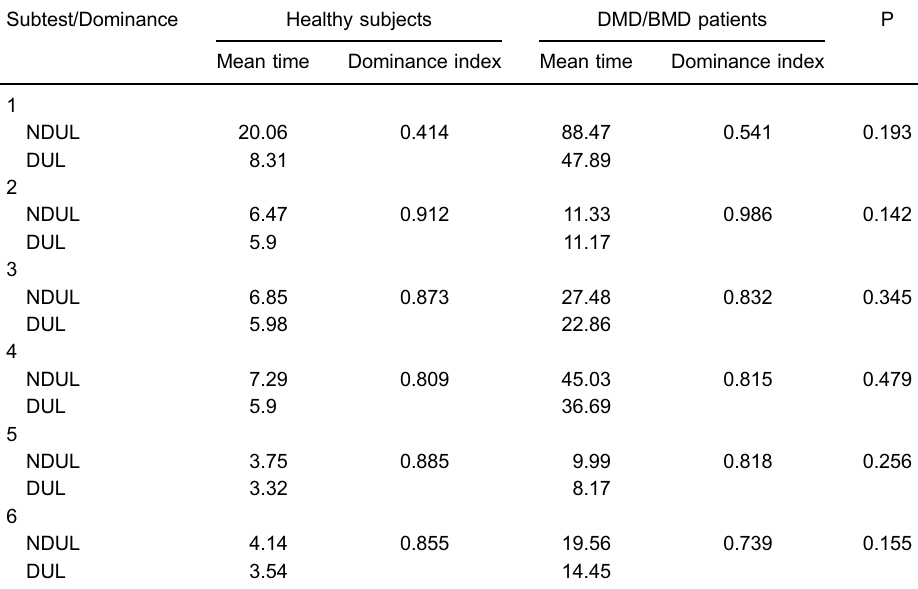
Table 2. Comparison between dominance index of healthy subjects and Duchenne and Becker muscular dystrophies (DMD/BMD) patients, based on Jebsen-Taylor subtests. Subtest/Dominance Healthy subjects DMD/BMD patients Mean